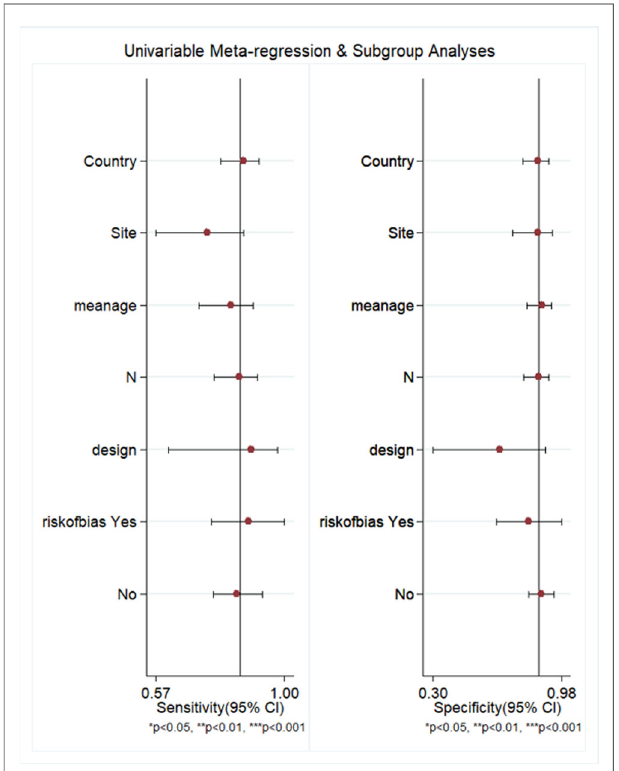
FIGURE 8 | Meta-regression for ascertaining sources of heterogeneity.